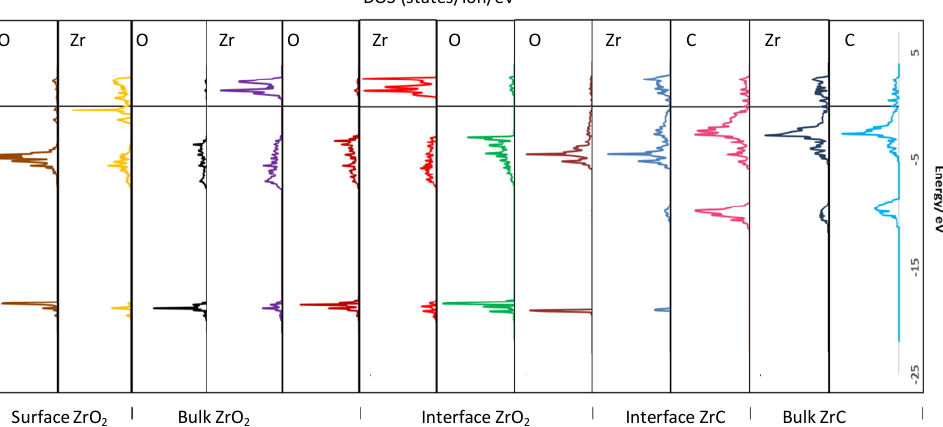
Figure 10. PDOS of atoms at the interface, in the bulk, and the exposed surface of the four c -ZrO 2 layer interface slab (Zr|OO|Zr|OO—ZrC(111)). The states are aligned parallel to the interface plane with each region marked on the top layer. The Fermi level is aligned at the zero energy position.